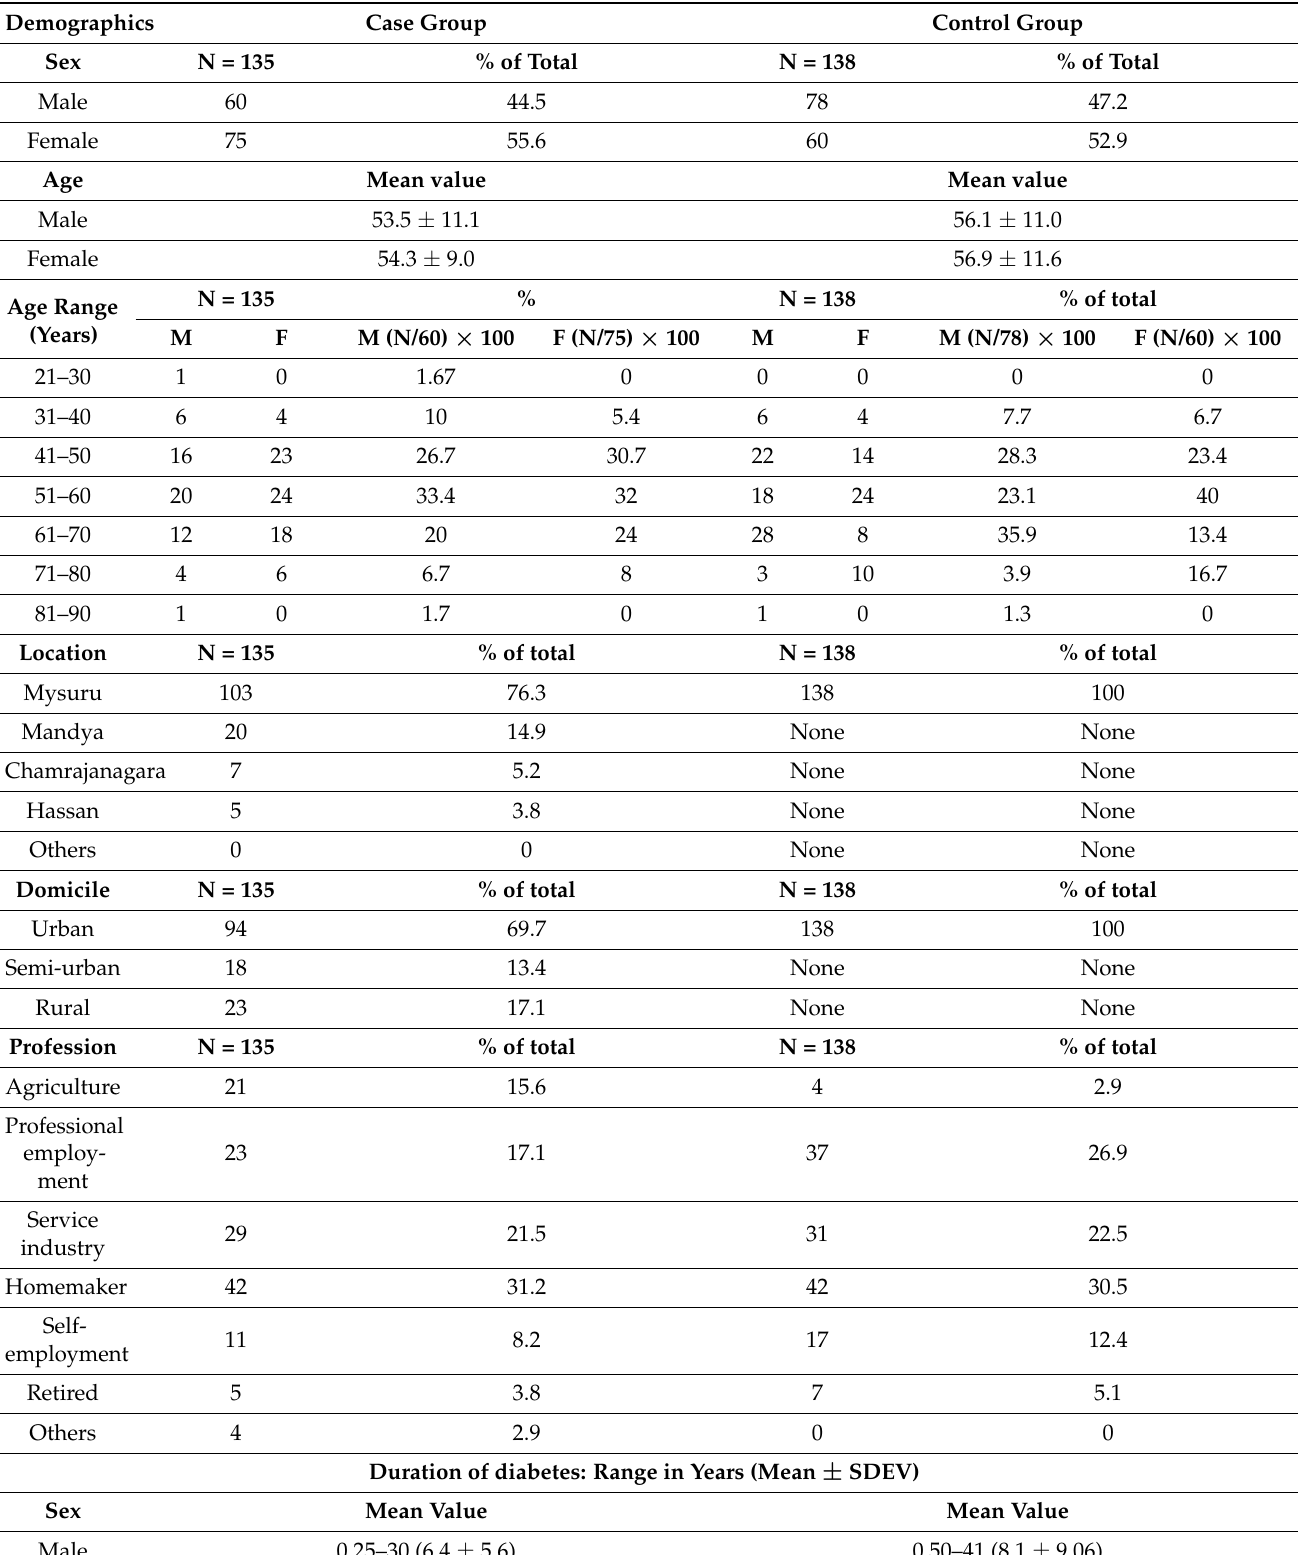
Table 1. Demographic information of the study participants in the parallel design RCT (please refer to Supporting Excel Sheet #S1 containing the statistical test